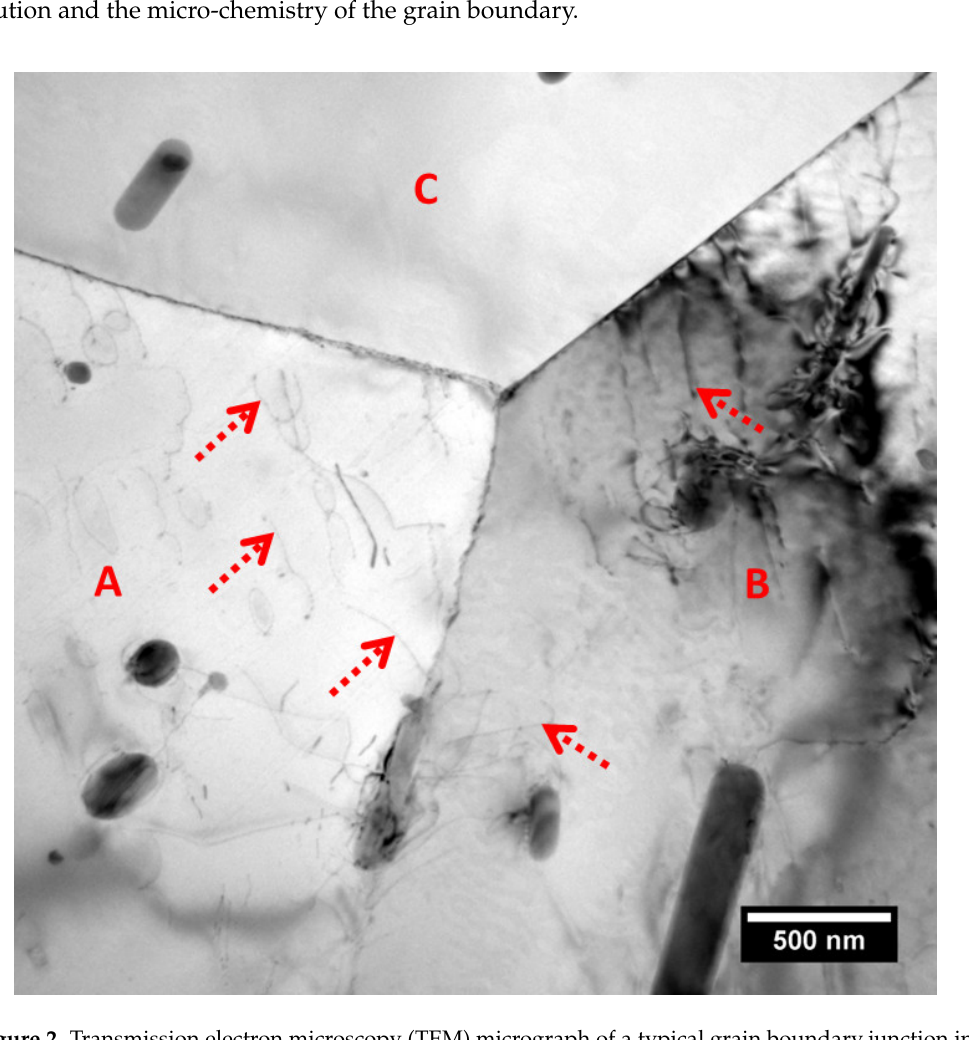
Figure 2. Transmission electron microscopy (TEM) micrograph of a typical grain boundary junction in AA2024‐T3 alloy.